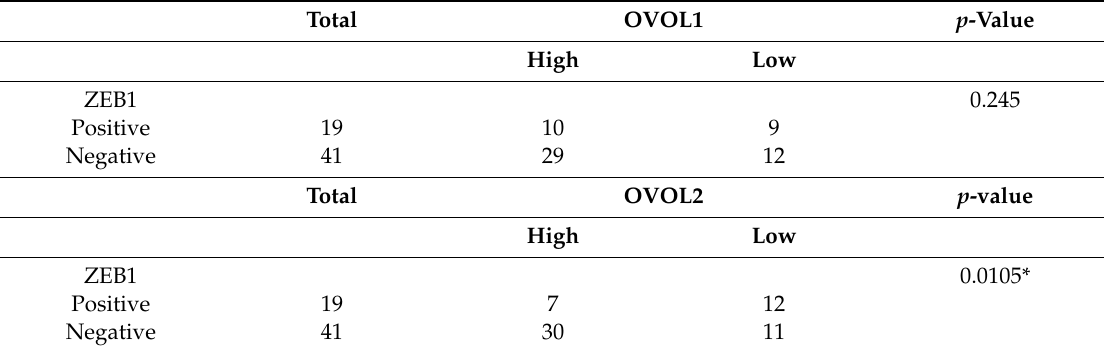
Table 2. Associations between OVOL1 / 2 and vimentin expression in AK and cSCC clinical samples. Total OVOL1 p -Value High Low Vimentin 0.352 Positive 15 8 7 Negative 45 31 14 Total OVOL2 p -value High Low Vimentin